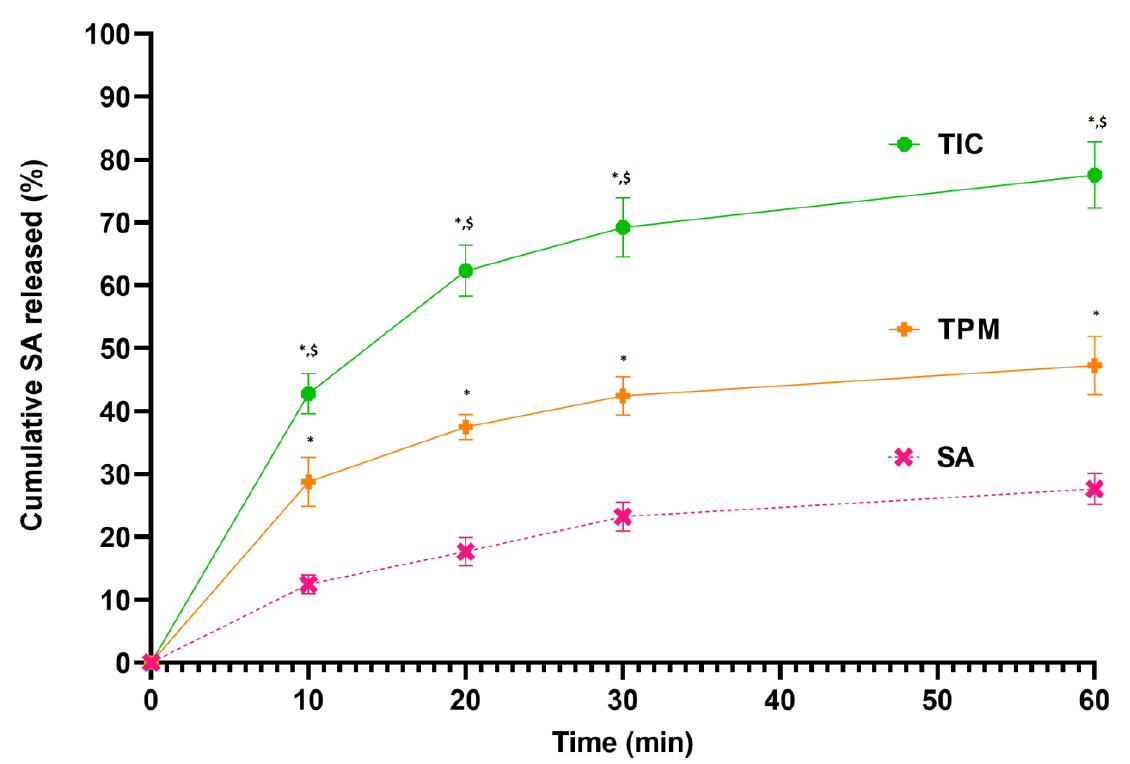
Figure 2. Dissolution profile of SA, TPM, and TIC, * p < 0.05 as compared to SA, $ p < 0.05 as compared to TPM.